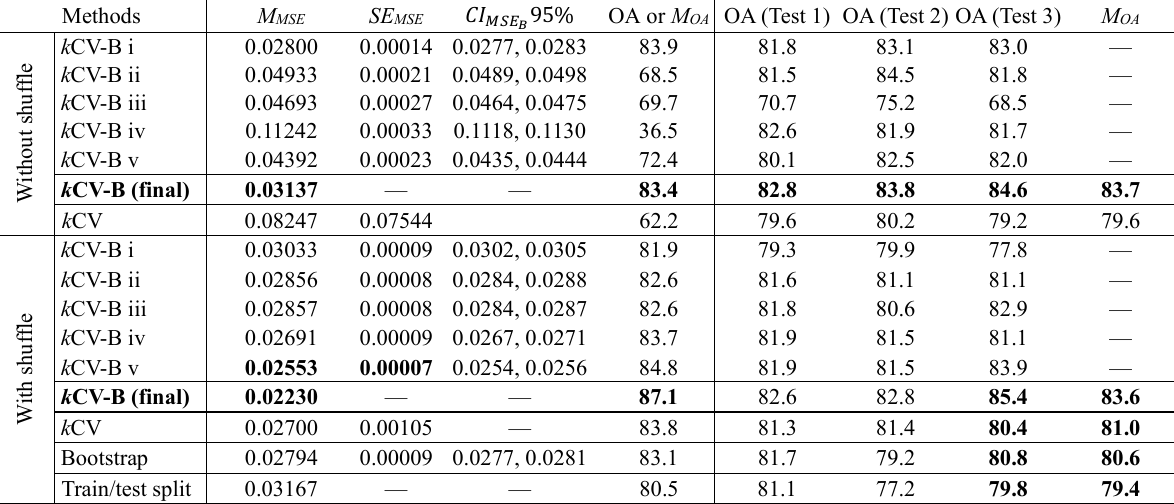
Table 1. Results of different methods for the validation data sets from different folds, and 3 test data sets. k CV-B (.) mentions k CV-B method when (.) is the fold used for